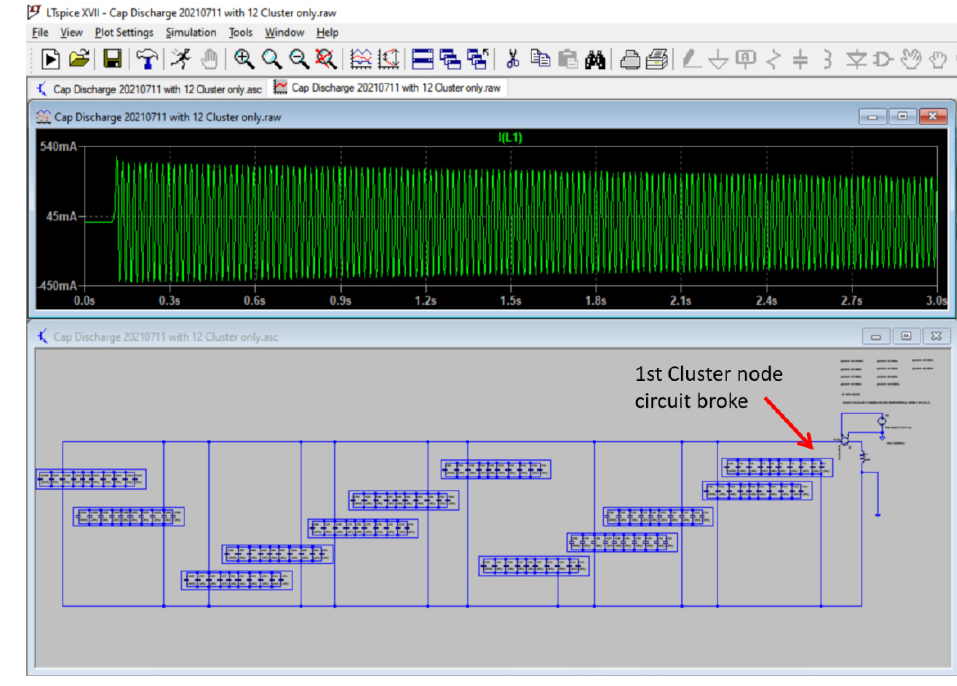
Figure 17. LTSPICE simulation with 12 capacitor-clusters.